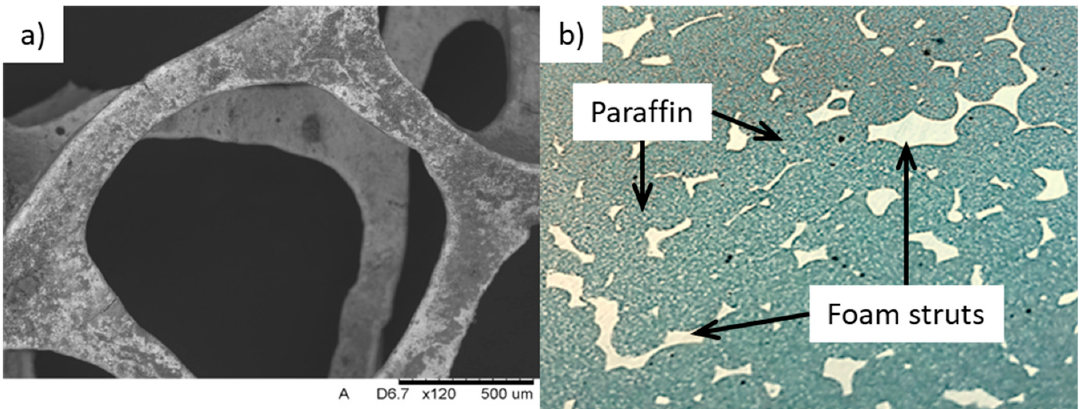
Figure 1. Casted Al–Si foam: ( a ) SEM (Scanning Electron Microscopy) micrograph, ( b ) composite PCM (Al–Si foam + paraffin).